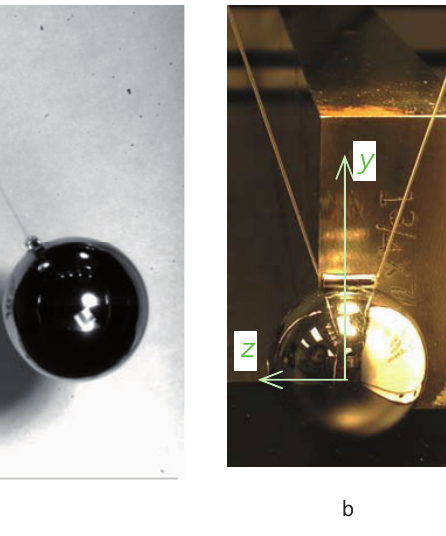
Fig. 1. Sphere suspended by two strings: a. xy plane view; b. yz plane